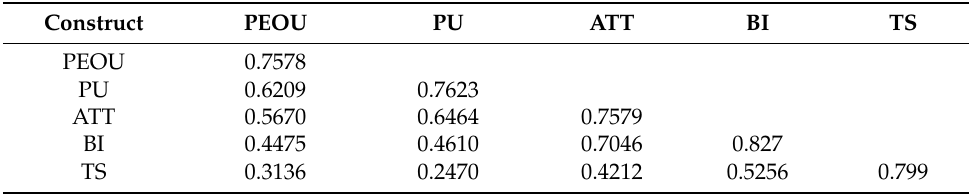
Table 8. Discriminant validity between constructs.